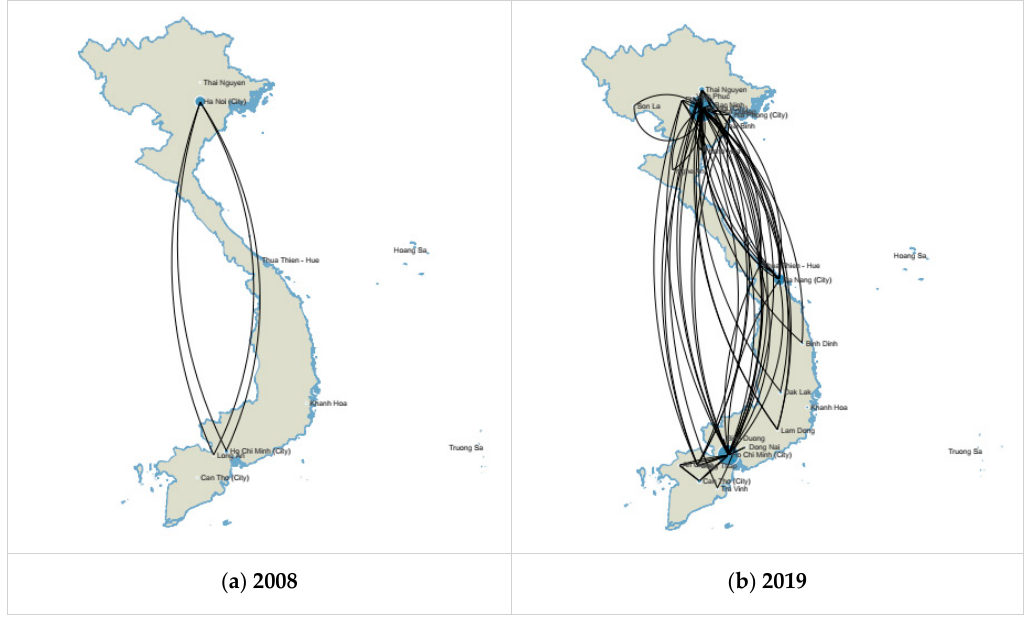
Figure 6. A map of Vietnamese domestic collaboration in ( a ) 2008 and ( b ) 2019 (last updated 30 April